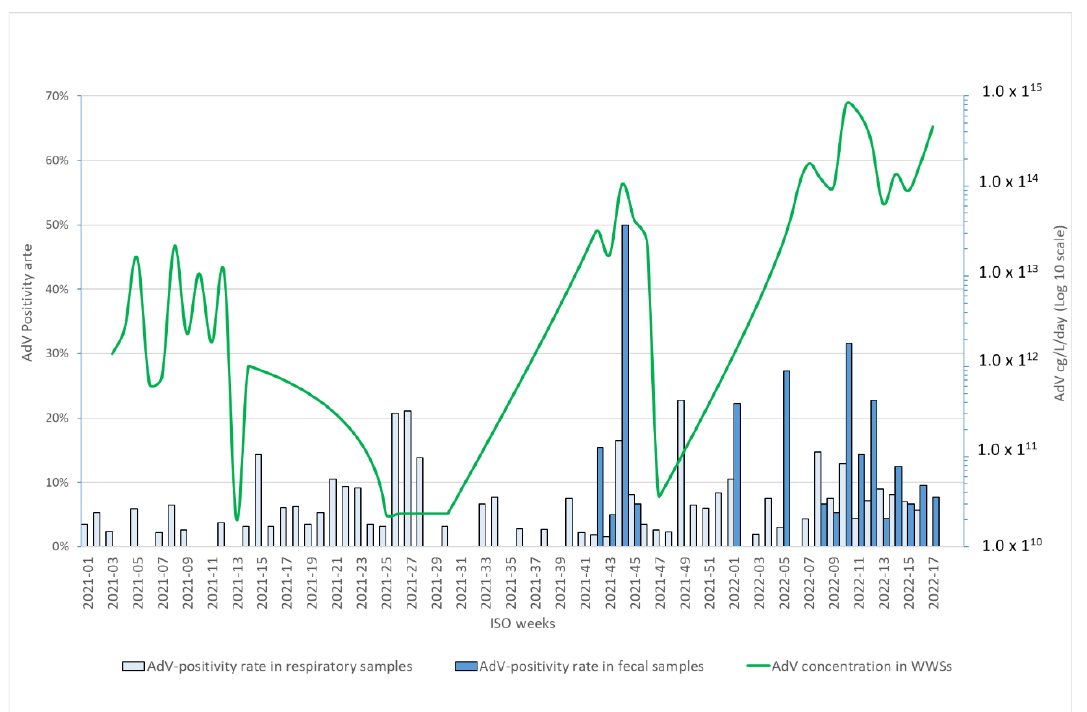
Figure 1. Quantification of AdV-DNA (cg/L/day) in urban wastewater samples collected in one wastewater treatment plant in Milan from week 2021-01 to week 2022-17 and the AdV-positivity rate by week in respiratory/fecal samples collected from inpatients with respiratory/gastroenteric infections at the Fondazione IRCCS Ca’ Granda Ospedale Maggiore Policlinico in Milan from week 2021-01 to week 2022-17.